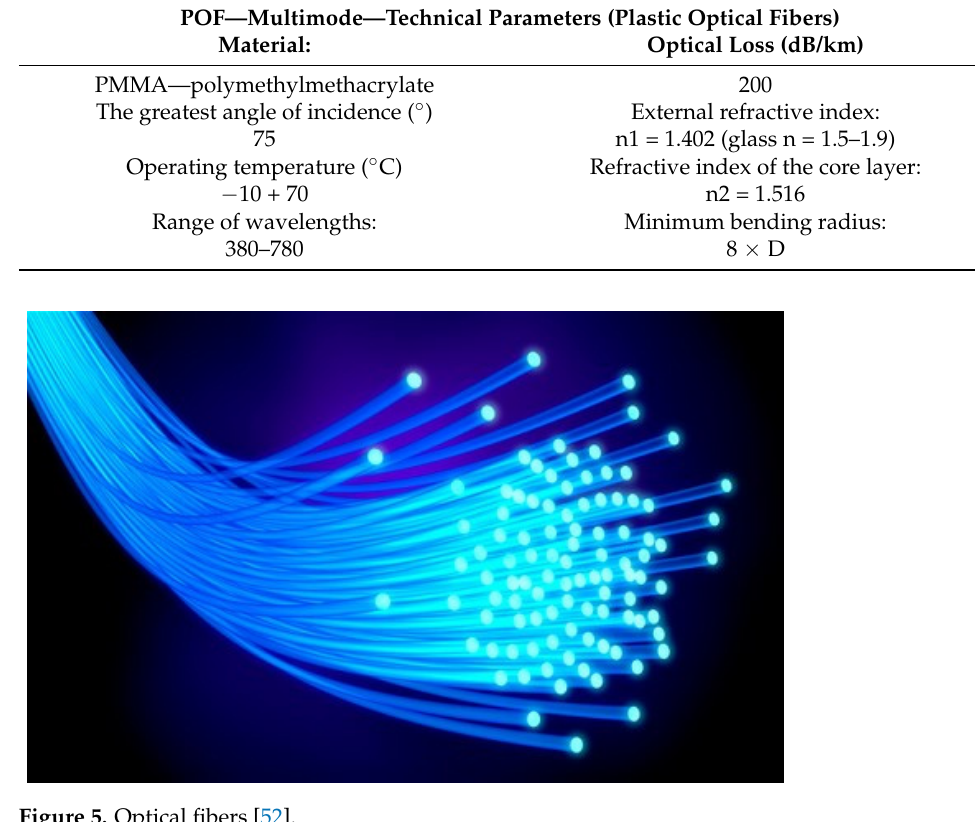
Figure 5. Optical fibers [52].